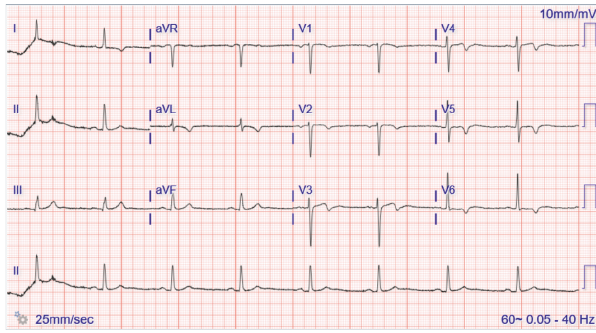
Figure 4: ECG 3 days later showing nonspecific ST-T wave changes